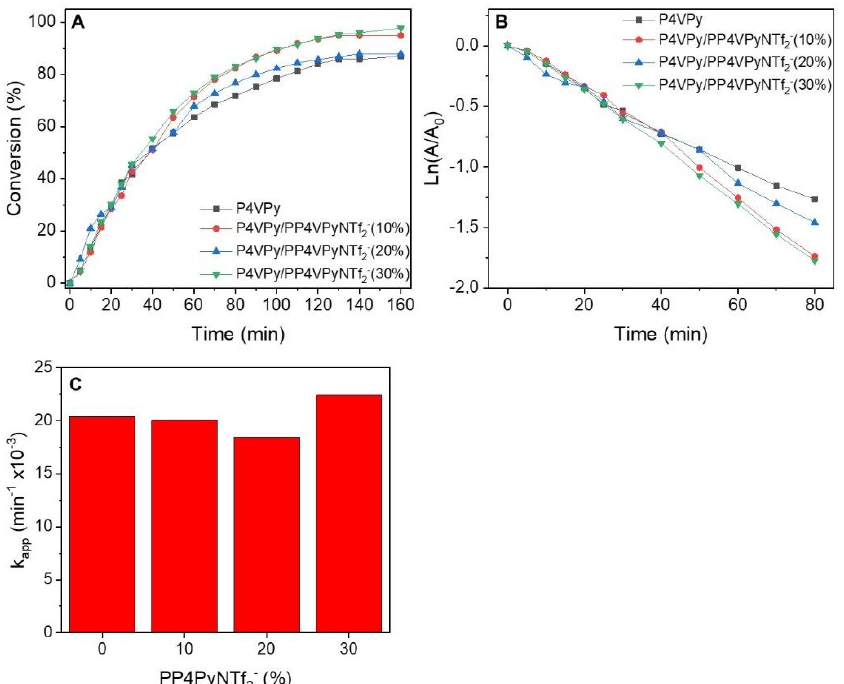
Figure 9. ( A ) Conversion profiles, ( B ) pseudo-first order model, and ( C ) apparent kinetic constant of the catalysts for the reduction in 4-nitrophenol into 4-aminophenol as a model reaction. In all cases, a rapid increase in the conversion percentage was initially observed, which slowed down as time progressed, until the highest conversion values were reached after 140 min of reaction. Interestingly, the highest value of 4 NP to 4 AP conversion (96%) was obtained with the nanofibers with the highest PIL content.